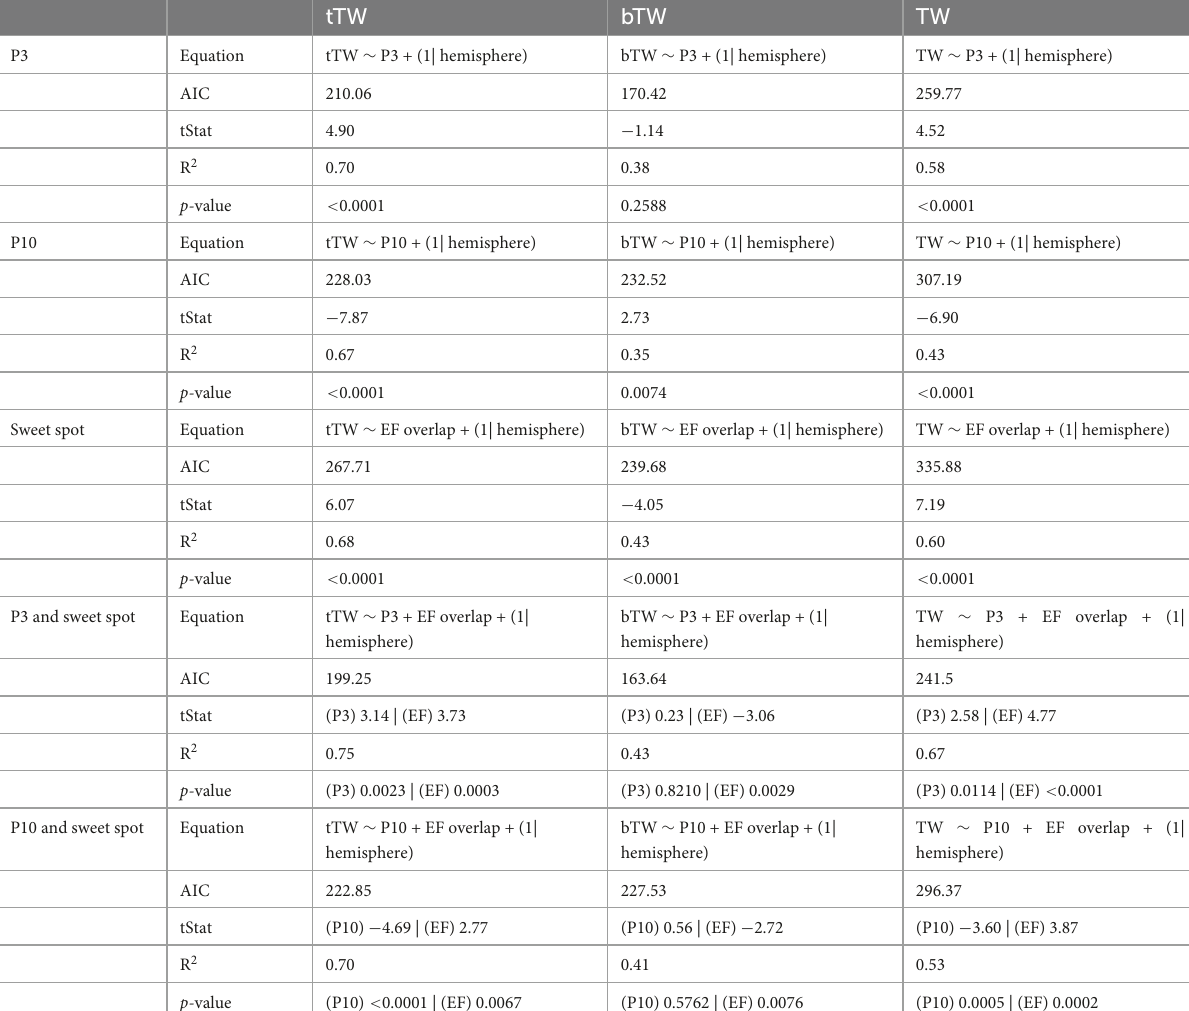
TABLE 2 Linear mixed model